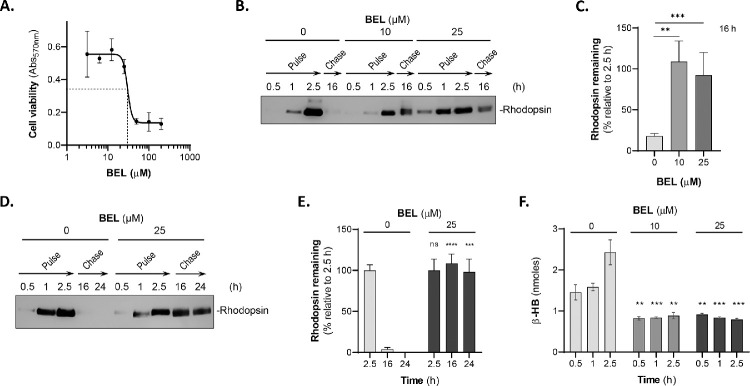
Phagocytosis in ARPE-19 cells pretreated with BEL. (A) ARPE-19 cells were incubated with BEL at the indicated concentrations for 3.5 hours. The mixture was then removed, washed gently with PBS, and incubated with complete medium for a total of 16 hours. Cell viability was assessed by crystal violet staining and with three replicates per condition. (B) Representative immunoblot of total lysates of cells pretreated with DMSO alone or 10- or 25-µM BEL/DMSO for 1 hour prior to pulse–chase of POSs, as described in Methods. Extracts of cells harvested at the indicated times (top of blot) were resolved by SDS-PAGE followed by immunoblotting with anti-rhodopsin. Migration position of rhodopsin is indicated to the right of the blot. (C) Quantification of rhodopsin from total lysates of cells of the pulse–chase experiments as in panel B. Samples from each biological replicate were resolved in duplicate by SDS-PAGE from two experiments and singly for the third experiment for quantification. Intensities of the immunoreactive bands were determined, and the percentages of the remaining rhodopsin after 16-hour chase relative to rhodopsin at 2.5-hour pulse were plotted. (D) Representative immunoblot of total lysates of cells, as in panel B to determine the effects of BEL at 16 hours and 24 hours of chase (as indicated). (E) Quantification of rhodopsin from two independent experiments of the pulse–chase experiments as in panel D. Samples from each biological replicate were resolved in duplicate by SDS-PAGE for quantification. Intensities of the immunoreactive bands were determined, and the percentages of the remaining rhodopsin after 16-hour chase relative to rhodopsin at 2.5-hour pulse were plotted. (F) Cells were preincubated with DMSO alone or 10- or 25-µM BEL/DMSO in Ringer's solution at 37°C for 1 hour. The mixture was then removed, and cells were incubated with Ringer's solution containing 5-mM glucose and POSs (1 × 107 units/mL) with DMSO alone or 10- or 25-µM BEL/DMSO for the indicated times (x-axis). Media were removed to determine the levels of β-HB secretion, which are plotted on the y-axis. Data are presented as mean ± SD. **P < 0.01, ***P < 0.001 (n = 3).